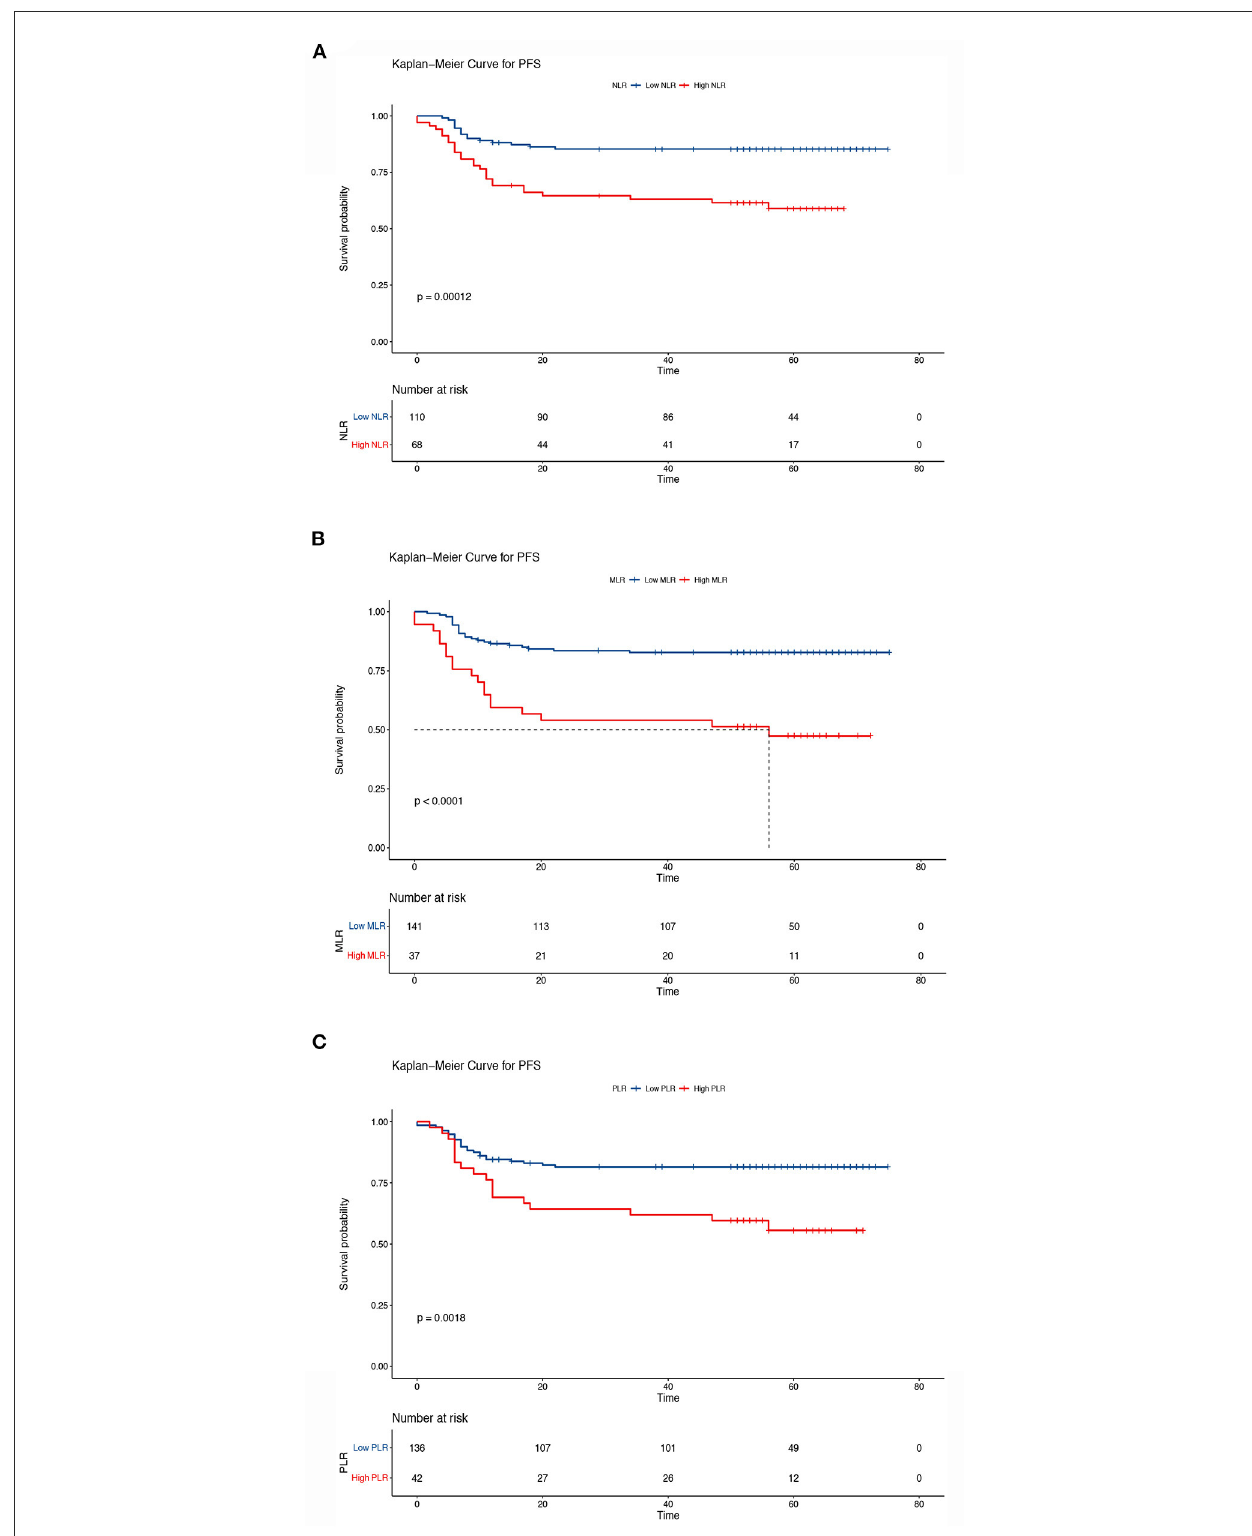
FIGURE6 Kaplan–Meier curves of progression-free survival according to the inflammatory indicators. (A) Low neutrocyte/lymphocyte ratio (NLR) vs. high NLR (low NLR: ≤ 2.8, high NLR: > 2.8), (B) low monocyte/lymphocyte ratio (MLR) vs. high MLR (low MLR: ≤ 0.41, high MLR: > 0.41), and (C) low platelet/lymphocyte ratio (PLR) vs. high PLR (low PLR: ≤ 186.67, high PLR: > 186.67). The Kaplan–Meier method was used to calculate the survival rate, and the log-rank test was used to compare survival distributions between the